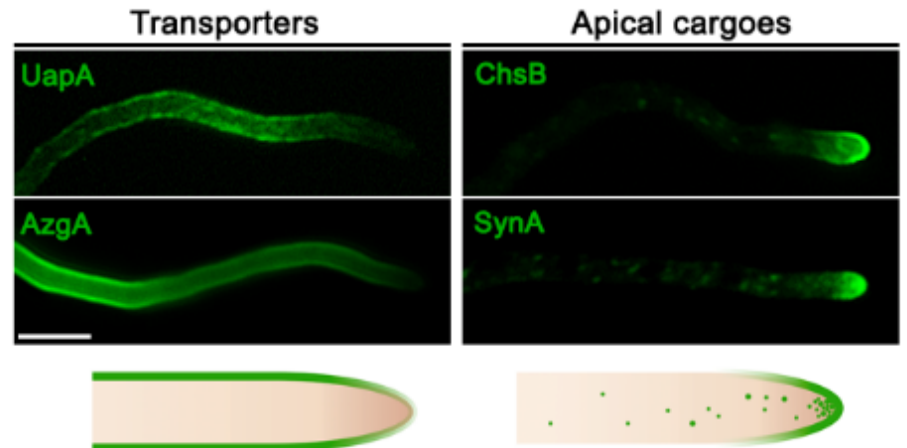
Figure 1. Localization of transporters versus apical markers in Aspergillus nidulans . Subcellular localization of transporters (UapA or AzgA) and apical membrane proteins (synaptobrevin SynA or chitin synthase ChsB) functionally tagged with green fluorescent protein (GFP) in hyphal cells of A. nidulans. Transporters localize homogenously along the plasma membrane, while apical cargoes are located at the hyphal membrane in a hemisphere extending from the apex to the endocytic collar, as well as in the Spitzenkörper and numerous secretory vesicles.